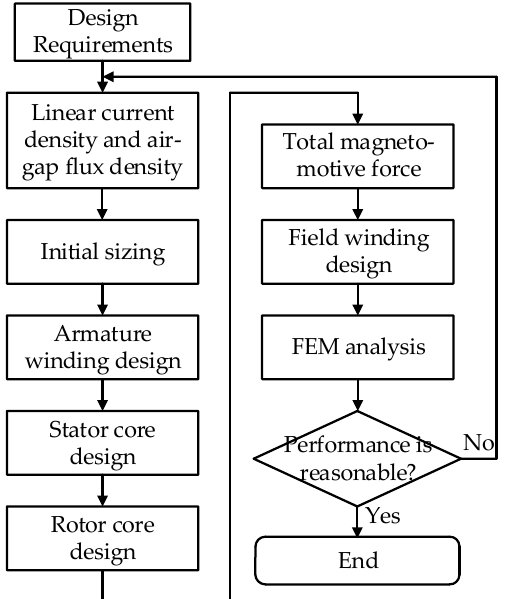
Figure 4. Schematic diagram of the conventional main generator electromagnetic design flow. For v a riable frequency BSGs, the power quality requirements are more difficult to meet under high-speed conditions, so extra attention is needed in the electromagnetic de- sign process. The most important power quality requirements are the harmonic content of the output voltage and the voltage unbalance and phase shift under the unbalanced load, the latter determined by the MG ’ s negative sequence impedance [22]. There are three main influencing factors, which are analyzed in detail as follows.